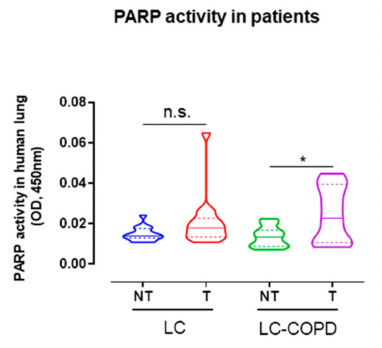
Figure 2. Violin plots with median (continuous lines) and interquartile ranges (discontinuous lines) of PARP activity levels in non-tumor and tumor lung specimens of LC and LC-COPD patients. Statistical significance: n.s., no significance, * p < 0.05 between non-tumor and tumor specimens of LC-COPD patients. Definition of abbreviations: PARP, poly (ADP-ribose) polymerase; OD, optical densities; LC, lung cancer; COPD, chronic obstructive pulmonary